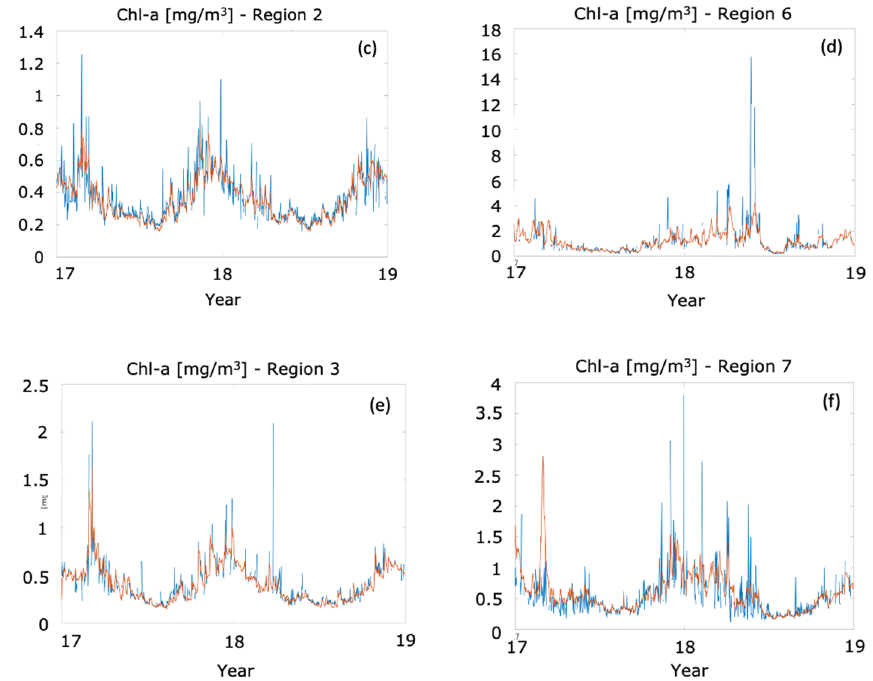
Figure 11. Time series of satellite (in blue) and model (in orange) chlorophyll spatial averages computed for optical characteristic regions as highlighted by [49].